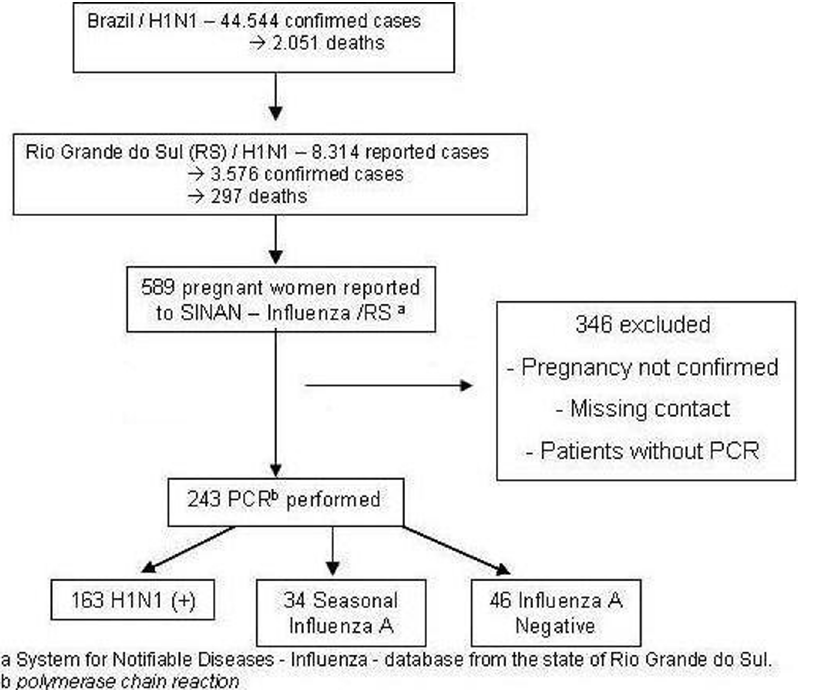
Figure 1. H1N1 cases reported, confirmed, and with a PCR performed, in Rio Grande do Sul. Footnote: a. Information System for Notifiable Diseases-Influenza (SINAN-Influenza): database for the state of Rio Grande do Sul. b. Polymerase chain reaction.